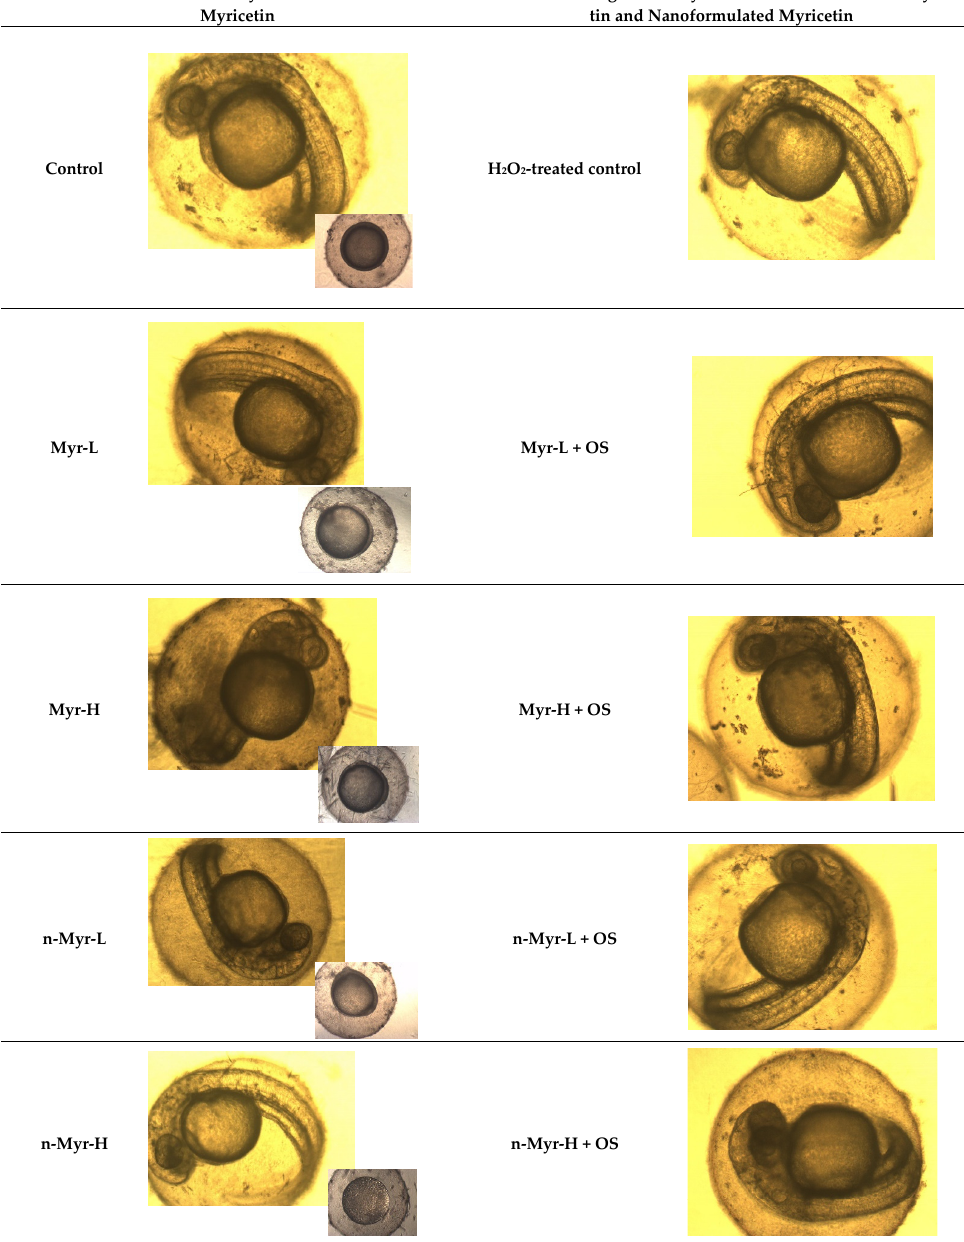
Figure 5. The images of zebrafish embryos after treatment with ( A ) low and high doses of myricetin (Myr-L and Myr-H) and nanoformulated myricetin (n-Myr-L and n-Myr-H) at 14 hpf (inset) and 36 hpf, respectively. ( B ) Zebrafish embryos (36 hpf) after treatment with hydrogen peroxide at 3 mM (H 2 O 2 -treated control) and 24 h after treatment with myricetin at low (Myr-L + OS) and high (Myr-H + OS) doses and with liposomal-nanoformulated myricetin at low (n-Myr-L + OS) and high (n-Myr-H + OS) doses and then exposed to oxidative stress (hydrogen peroxide, 3